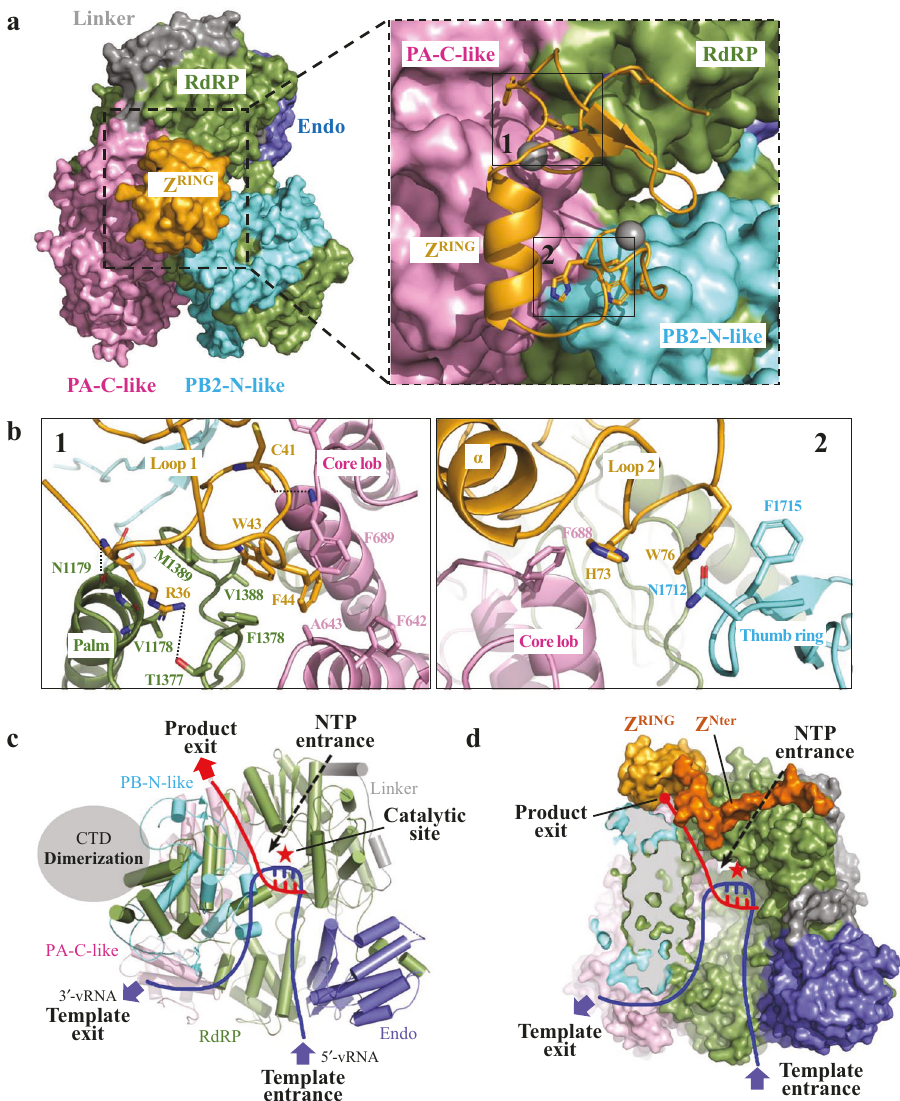
Fig. 3 Molecular details of the interaction between the Z and L proteins. a Surface diagram of the L – Z complex with the domains indicated and colored as in Fig. 1a. Inset zoom, the Z protein is represented as ribbon with the two binding sites outlined with black boxes and shown in ( b ). b Detailed views of the two interfaces between the Z and L proteins. Left, loop 1 of Z interaction with palm and core lob of the L protein; Right, loop 2 interaction with core lob and thumb ring. The backbones of L and Z are in ribbons representation. Side chains and main chains involved in interactions are shown as sticks and labeled. Oxygen, nitrogen and sulfur atoms shown in red, blue and yellow, respectively, and salt bridges and hydrogen bonds are indicated as black dashed lines. c Cartoon model of the L protein showing putative tunnels of the template RNA entrance (blue line) and exit (blue dashed line), the product exit (red line) and NTP entrance (black dashed arrow). The catalytic site is indicated by a red asterisk and the CTD is is represented by a gray oval. d Surface representation of L inhibited by Z binding. The RdRP and PB2-N-like domain are partially showed as cut-out view to better display the product RNA exit. The RING domain of Z is colored bright orange, and the modeled N-terminus of MACV Z using LASV Z (PDB 5I72) as template is colored dark orange. The hidden product exit tunnel is showed as red dashed